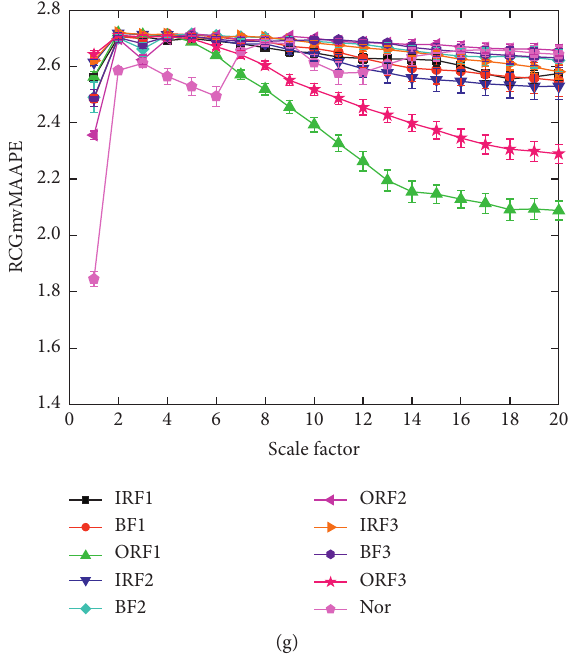
Figure 11: The entropy results of rolling bearing data analyzed by using seven